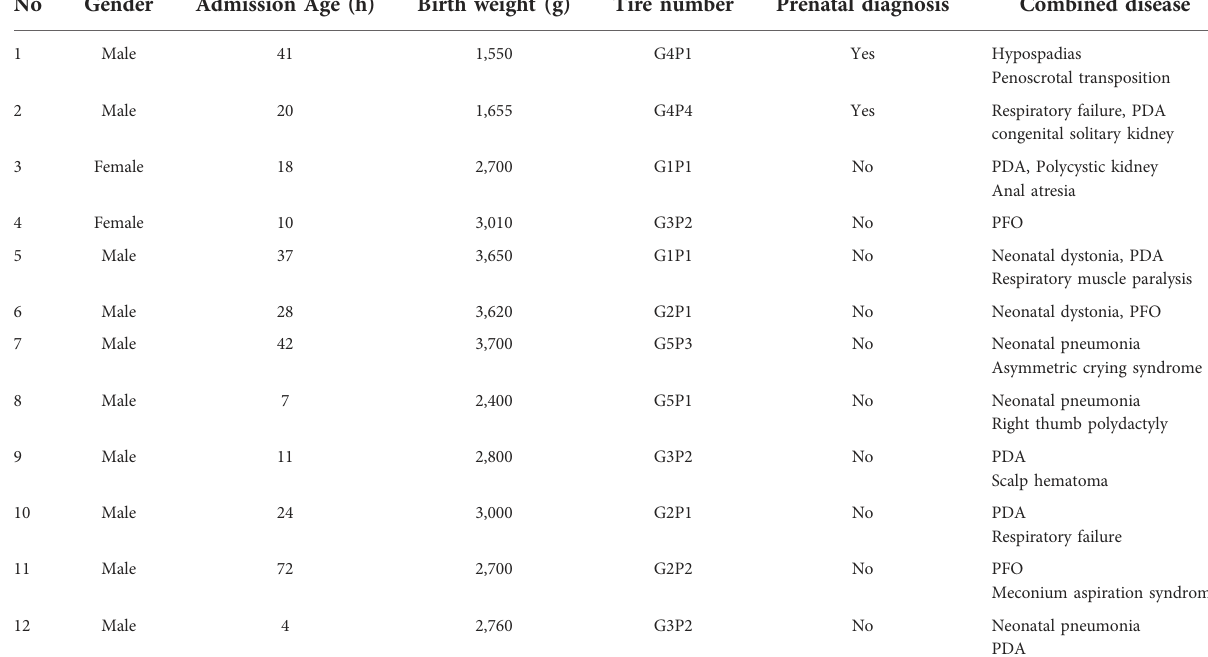
TABLE 2 Patient demographics, preoperative status. No